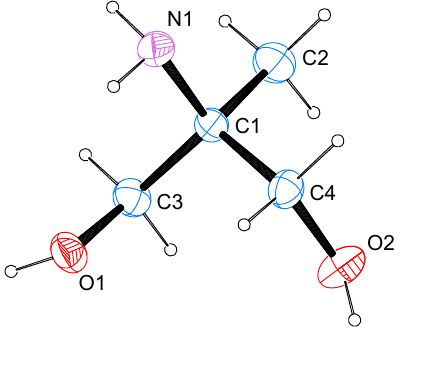
Table  : Data collection and handling.